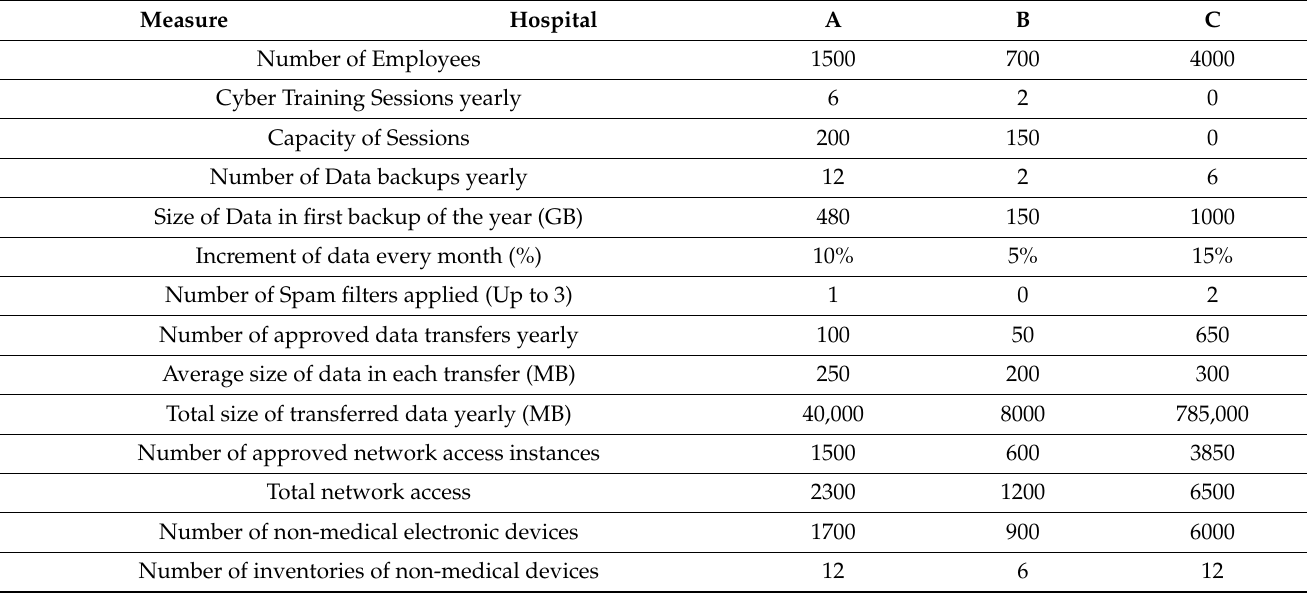
Table 2. Datasets from three different hospitals that will be used to test and validate the evaluation